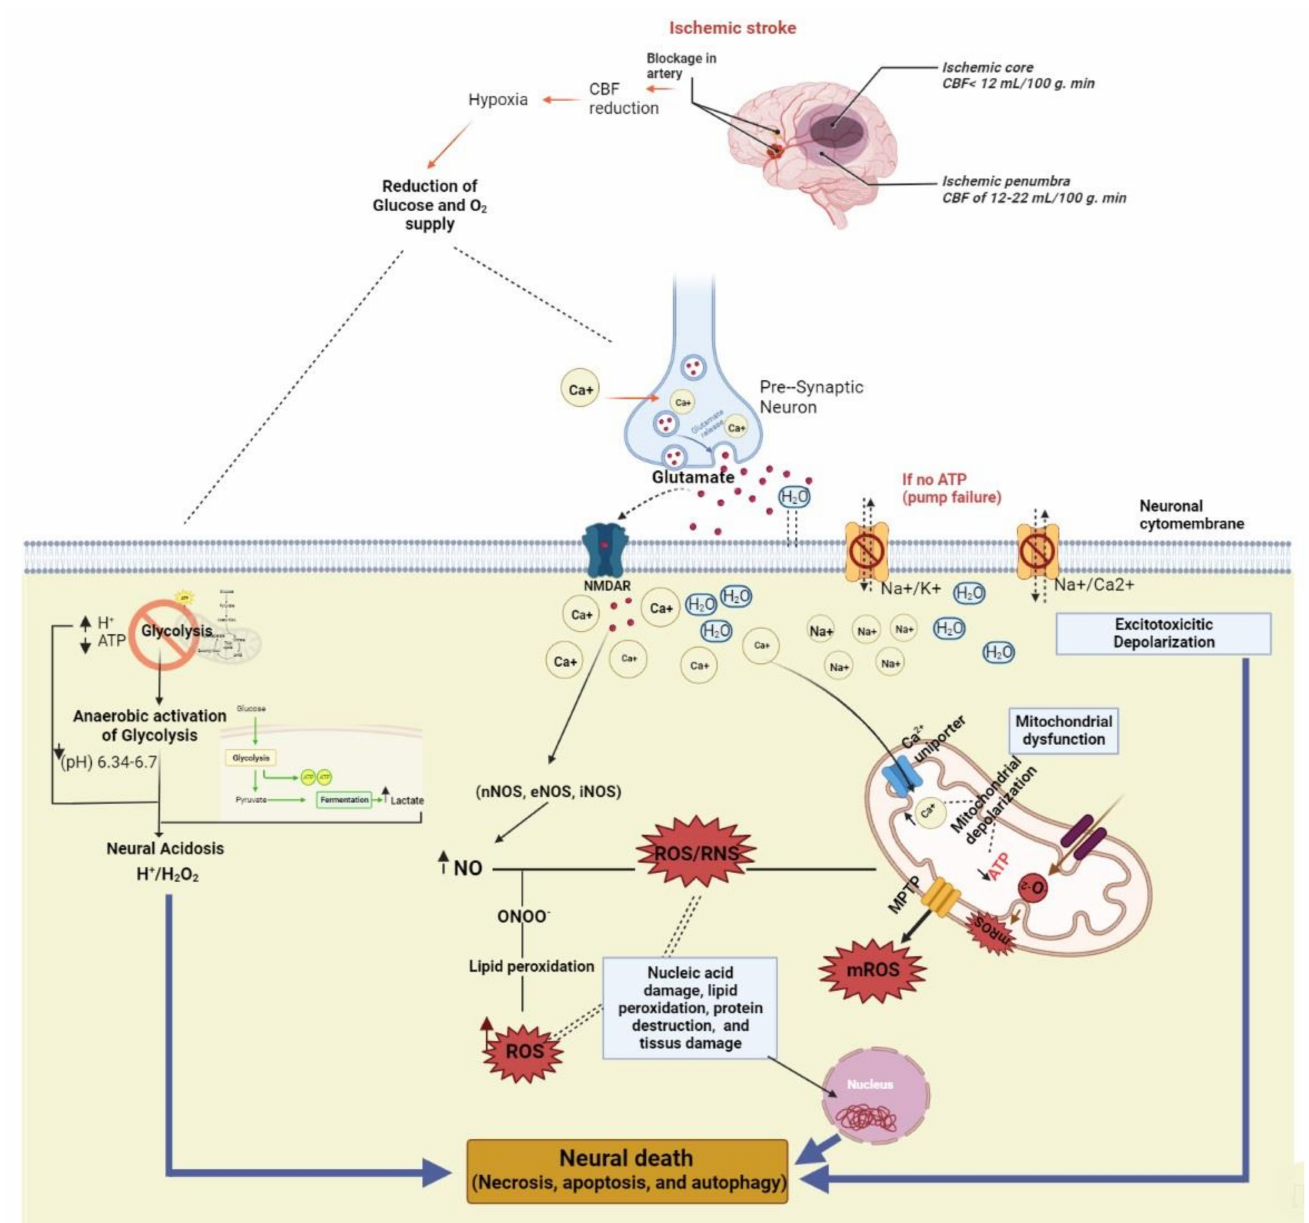
Figure 1. Oxidative stress pathways in pathophysiology of ischemic